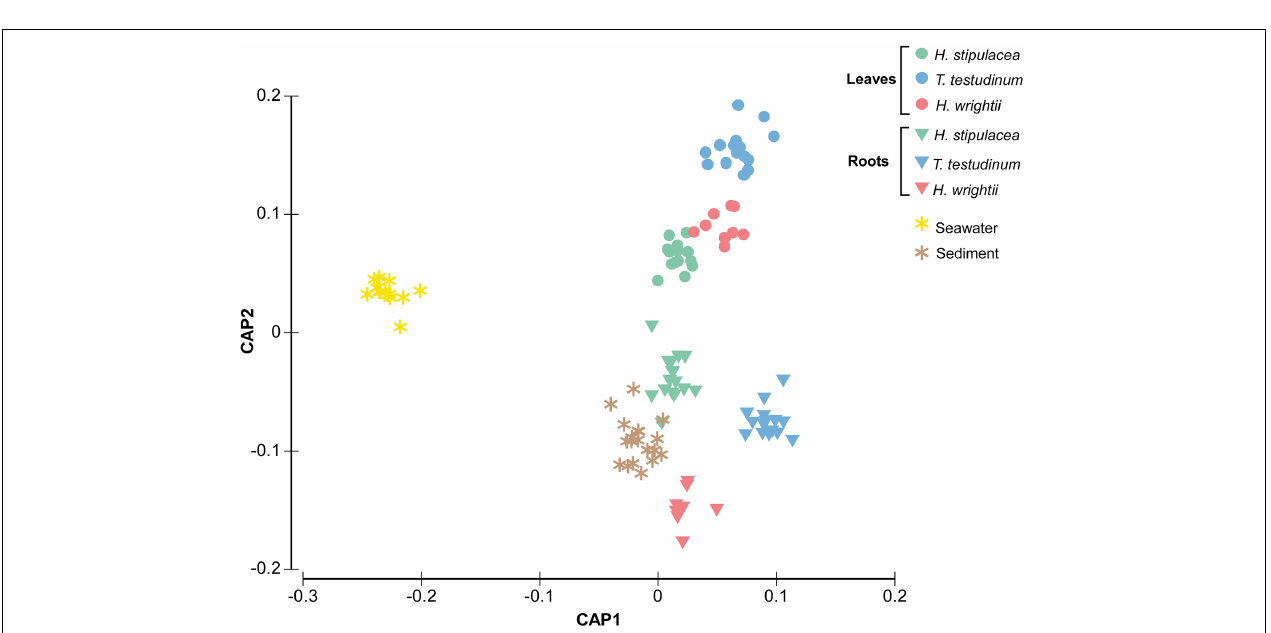
FIGURE 3 | Canonical analysis of principal coordinates (CAP) ordination plot (based on Bray–Curtis dissimilarity matrix of square root transformed bacterial abundances) showing canonical axes that best discriminate the bacterial community assemblages of the native seagrasses H. wrightii and T. testudinum and the invasive H. stipulacea across leaves and roots tissues as well as seawater and sediment in six bays of the Caribbean island of Curaçao. Colors were changed so the different species’ colors would match with the other figures.